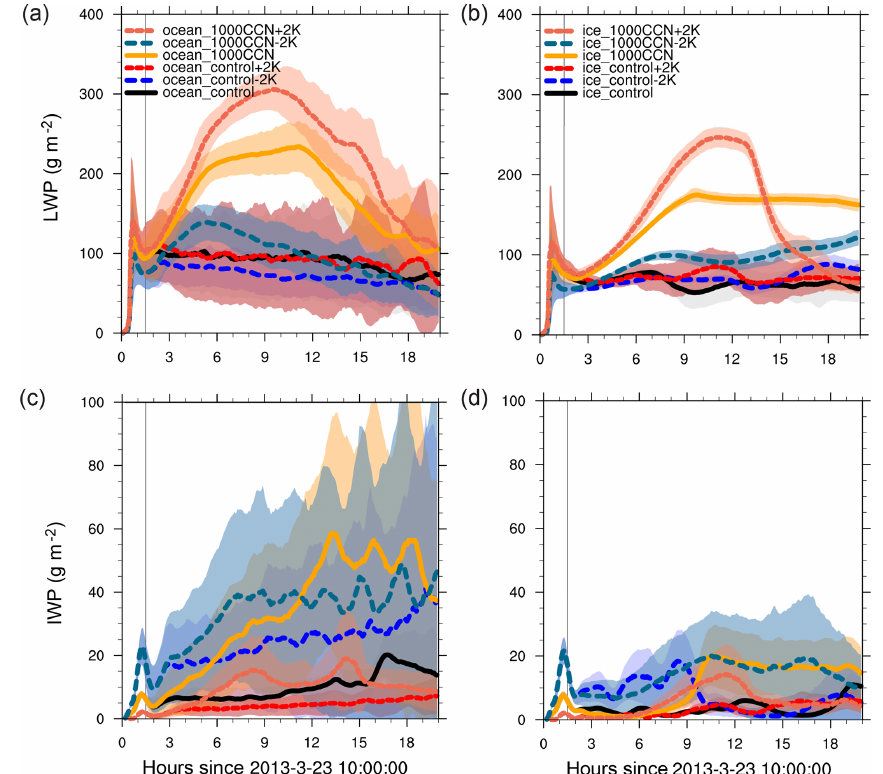
Figure 10. Domain-averaged (a, b) LWP and (c, d) IWP over the open ocean (a, c) and sea ice (b, d) in control and the respective 1000CCN simulations in their regular state and 2K warmer and colder conditions. The lines depict the means, the shadings the standard deviations. The vertical black lines indicate the CCN perturbation